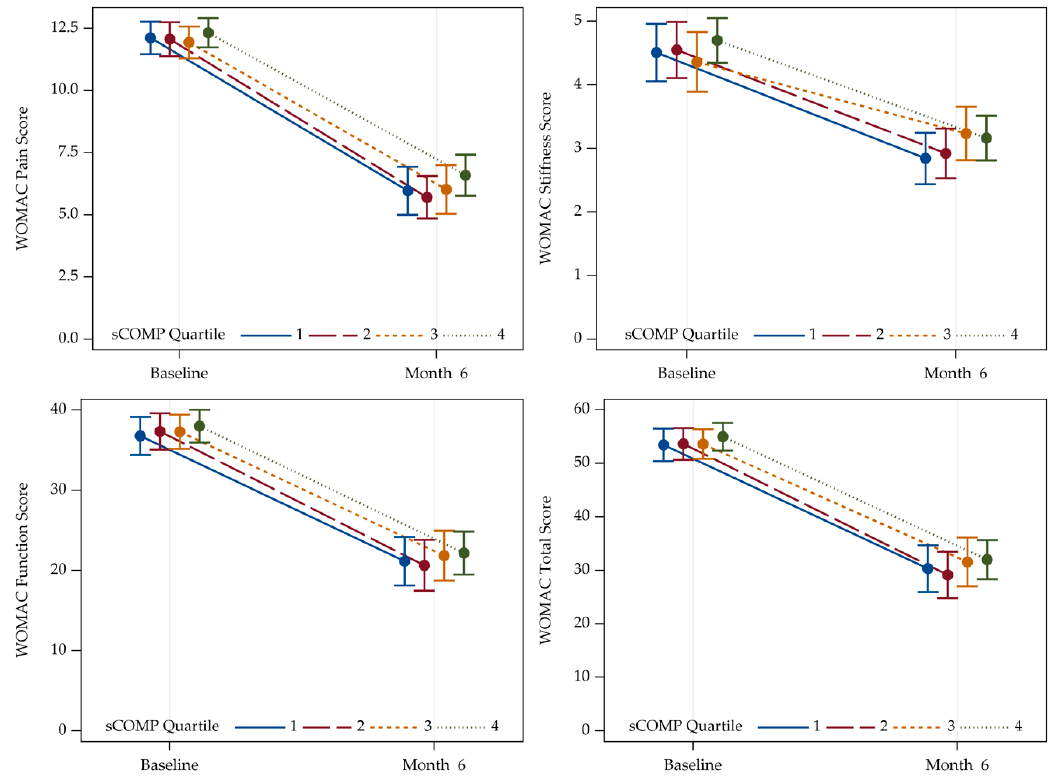
Figure 2. Trajectories of separated WOMAC sub-scales pain ( A ), stiffness ( B ), and function ( C ), and total WOMAC scores ( D ) of patients with knee OA at baseline and six months follow-up. Higher values reflect more severe impairment. Values are given as means with two-sided 95% confidence limits. sCOMP Quartile 1: N = 79, Quartile 2: N = 85, Quartile 3: N = 88, Quartile 4: N = 108. WOMAC = Western Ontario and McMaster University Osteoarthritis Index; Q = quartile.